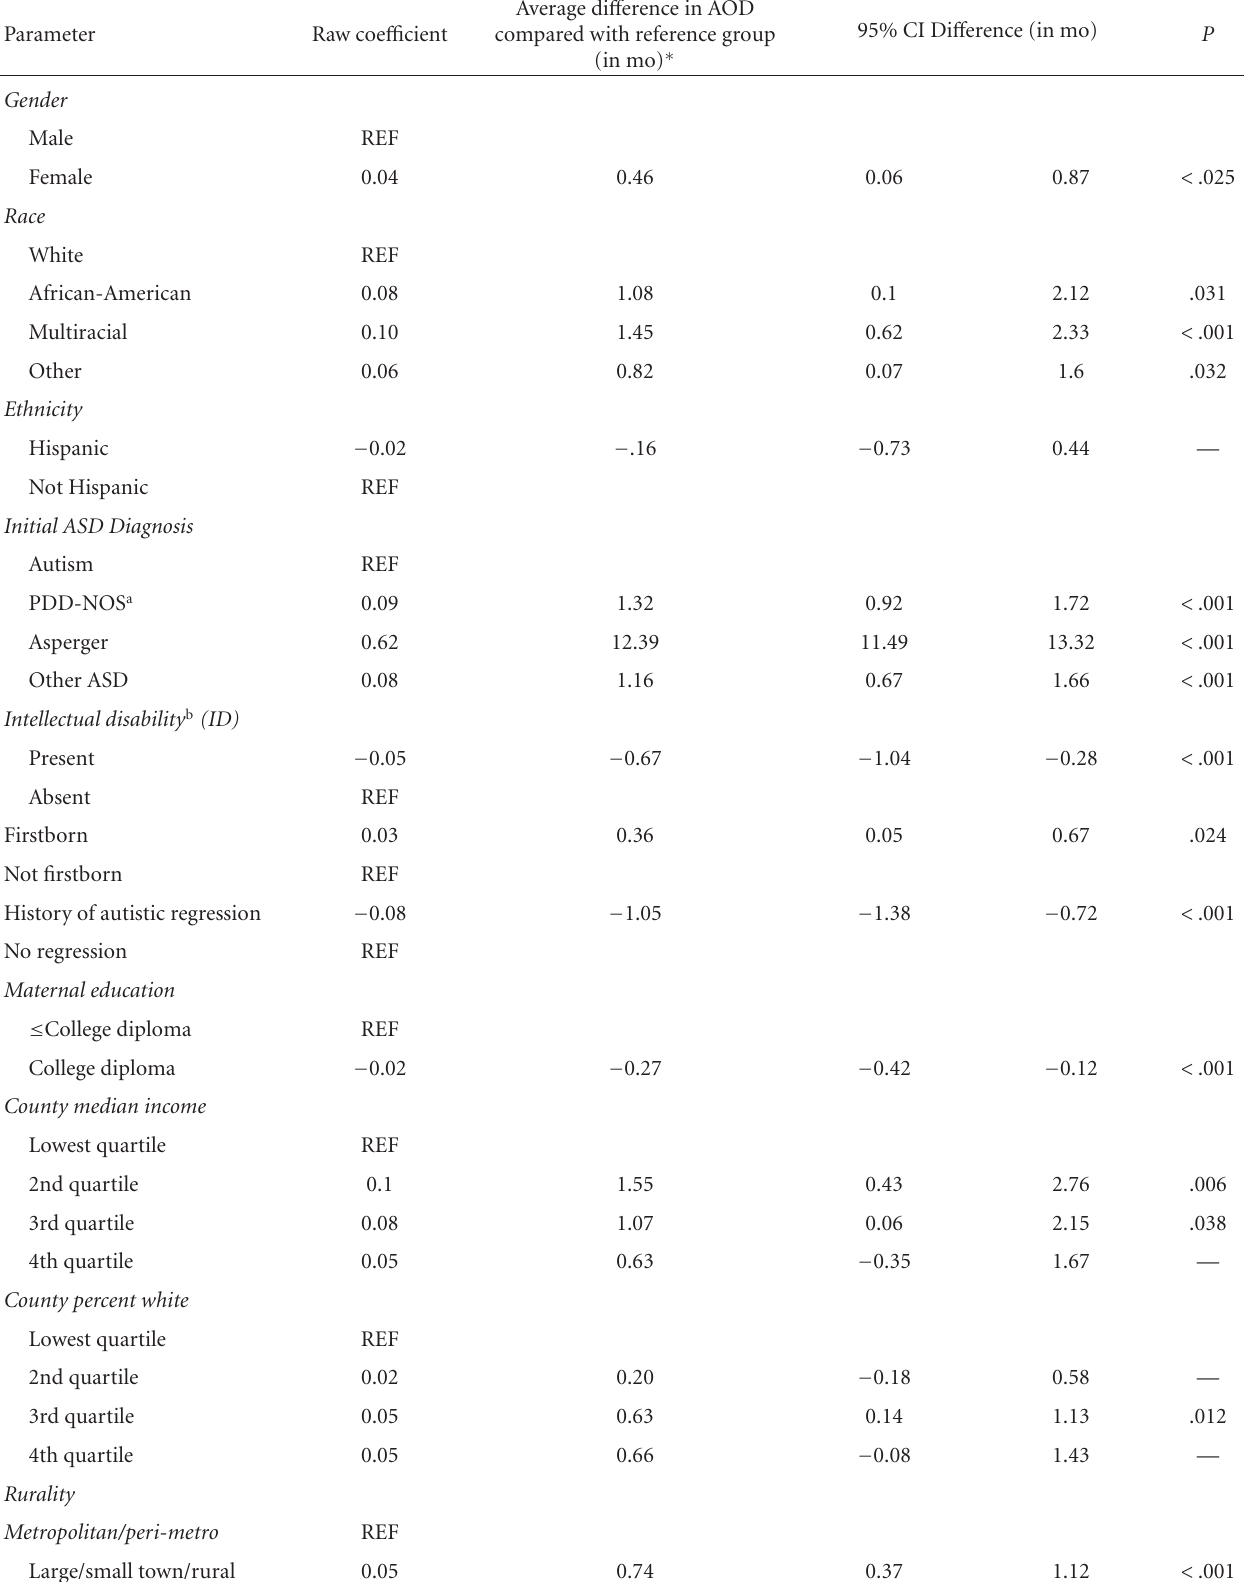
Table 3: Multivariate random-e ff ects linear regression model (clustering by state) of log-transformed age at initial ASD diagnosis (AOD), adjusted by age and age of concern ( n =